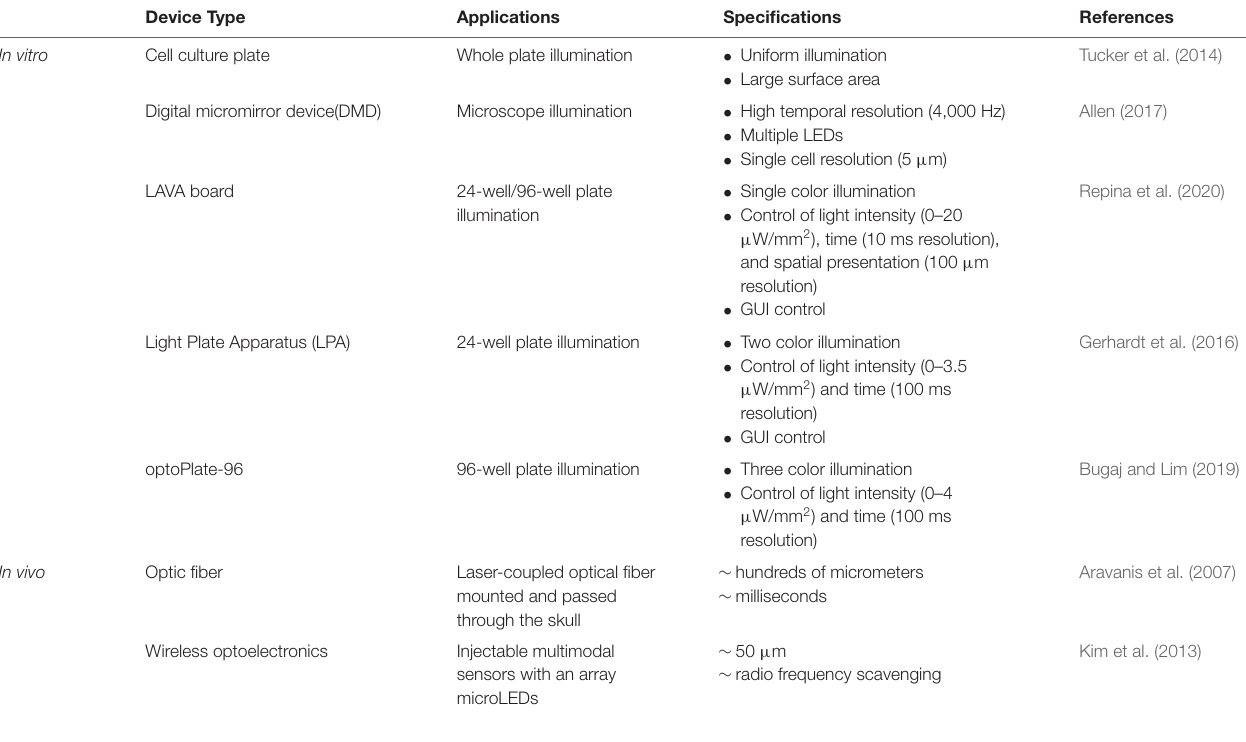
TABLE 2 | Existing optic hardware used in optogenetic illumination and their